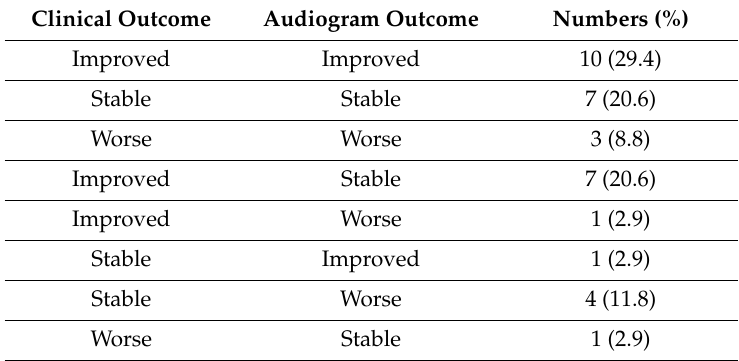
Table 3. Correlation between clinical and audiogram outcomes one year after treatment with penicillin G sodium treatment in otosyphilis patients ( n = 34).